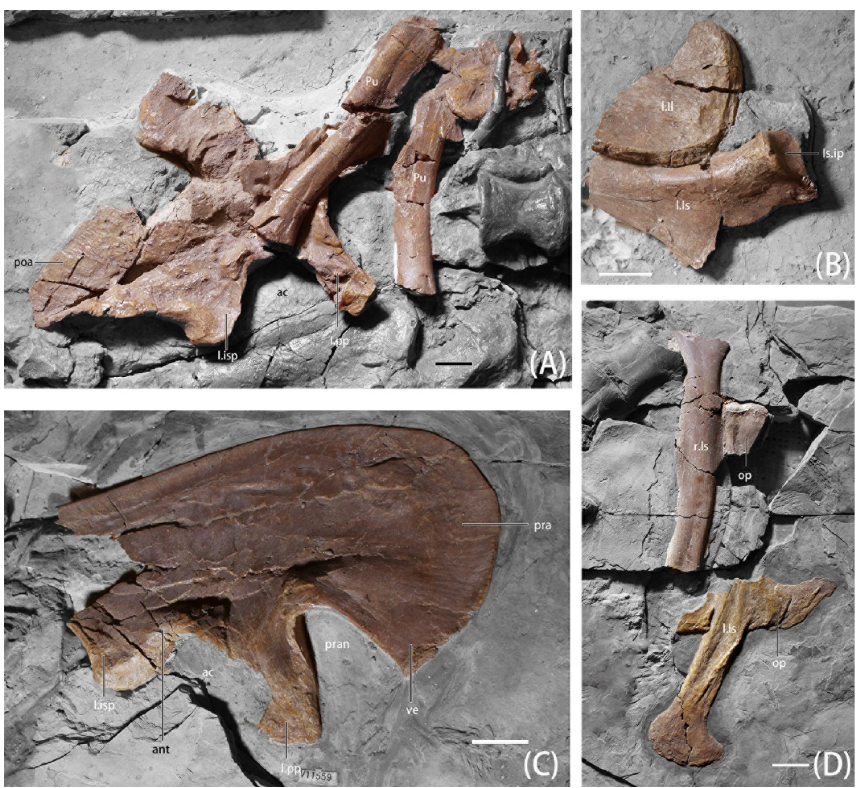
Fig 8. Photographs of pelvic girdle elements of B . inexpectus (IVPP V 11559) A. left ilium in medial view with pubis; B. partial ilium and ischium; C. right ilium in lateral view; D. right ischium in lateral view and left ischium in medial view. Abbreviations: ac , acetabulum; ant , antitrochanter; I.isp , ischiadic peduncle of ilium; I.pp , pubic peduncle of ilium; Is.ip , iliac peduncle of ischium; l.Il , left Ilium; l.Is, left ischium; op , obturator process; poa , postacetabular; pra , preacetabular; pran , preacetabular notch; Pu , pubis; r.Is , right ischium; ve , ventral extension. Scale bars equal 2 cm.